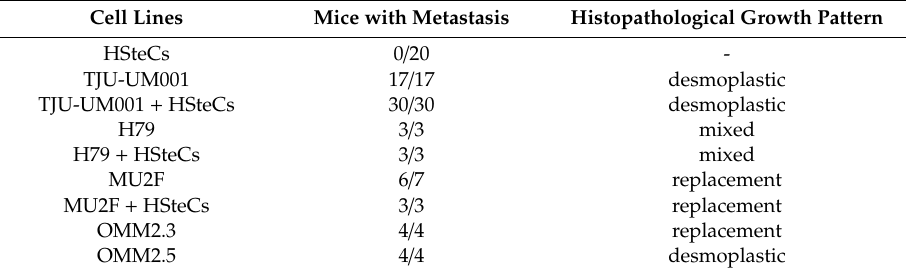
Table 2. Summary of liver metastasis formation in immunodeficient mice inoculated with human UM cell lines and